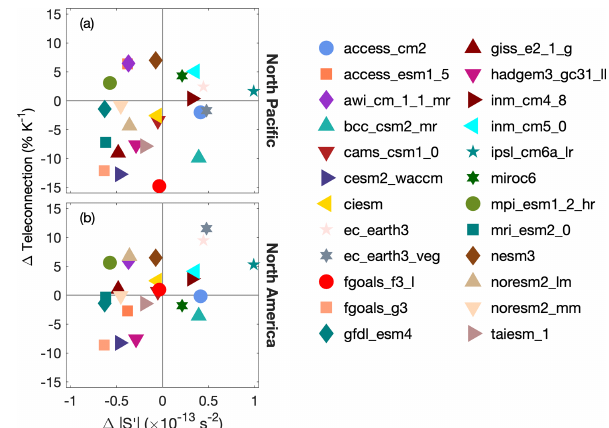
Figure 5. For individual CMIP6 model mean states, the difference in the Rossby wave source ( S (cid:48) ) versus the difference in the telecon- nection amplitude between simulations with historical and future mean state winds for (a) the North Pacific and (b) North America. The horizontal axis is the ensemble mean and time mean difference of the absolute value of S (cid:48) averaged over the subtropical jet (20– 40 ◦ N, 80–190 ◦